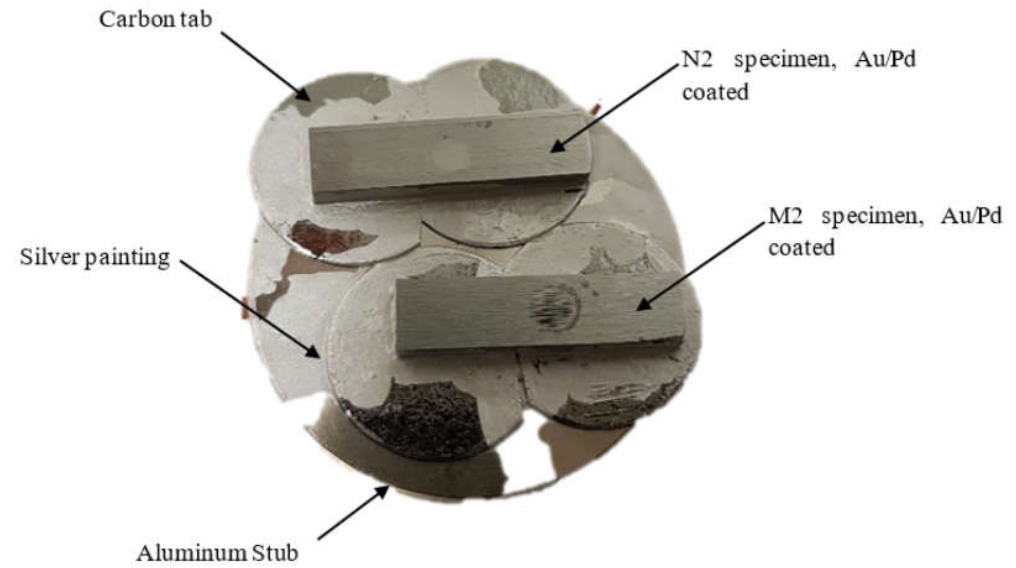
Figure 3. Specimens preparation for SEM imaging.